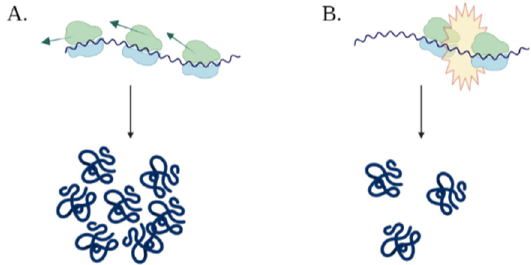
Figure 3. Illustration of the effect of translation modulation. Figure ( A ) describes the effect of translation optimization, causing increased ribosomal flow when efficient codons are used, while figure ( B ) showcases the opposite effect, where ribosomes collide and create traffic jams.